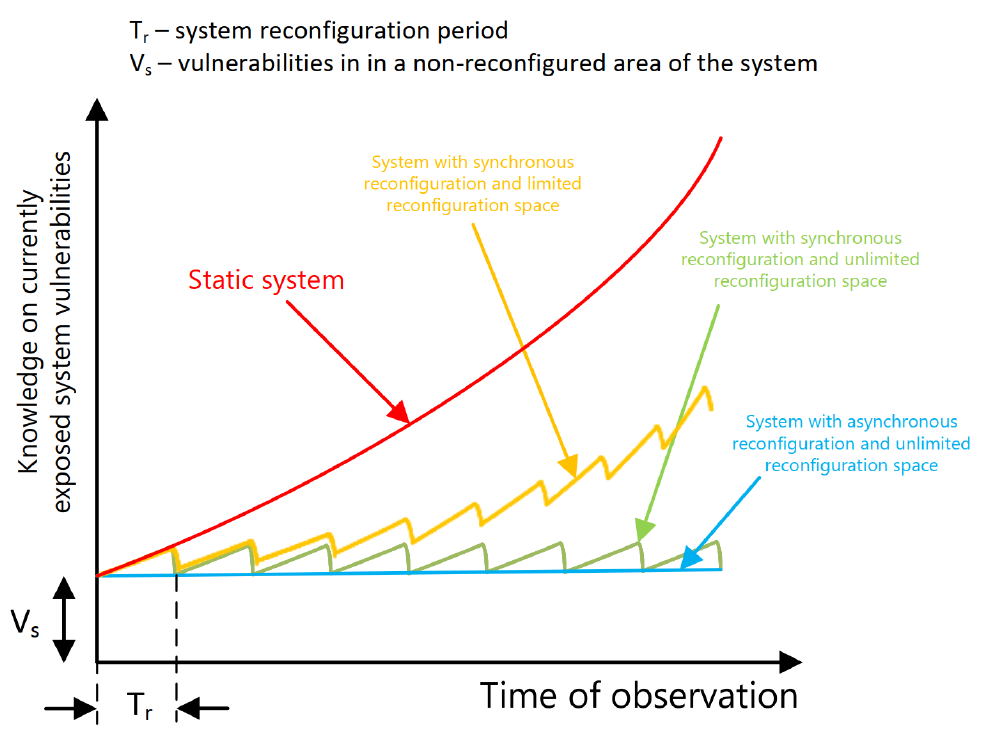
Figure 2. Knowledge of system vulnerabilities vs. time of observation for static system and system with